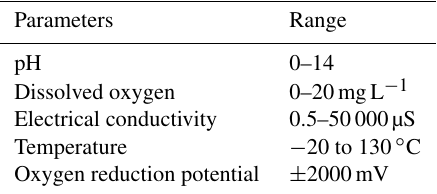
Table 2. Sensor array